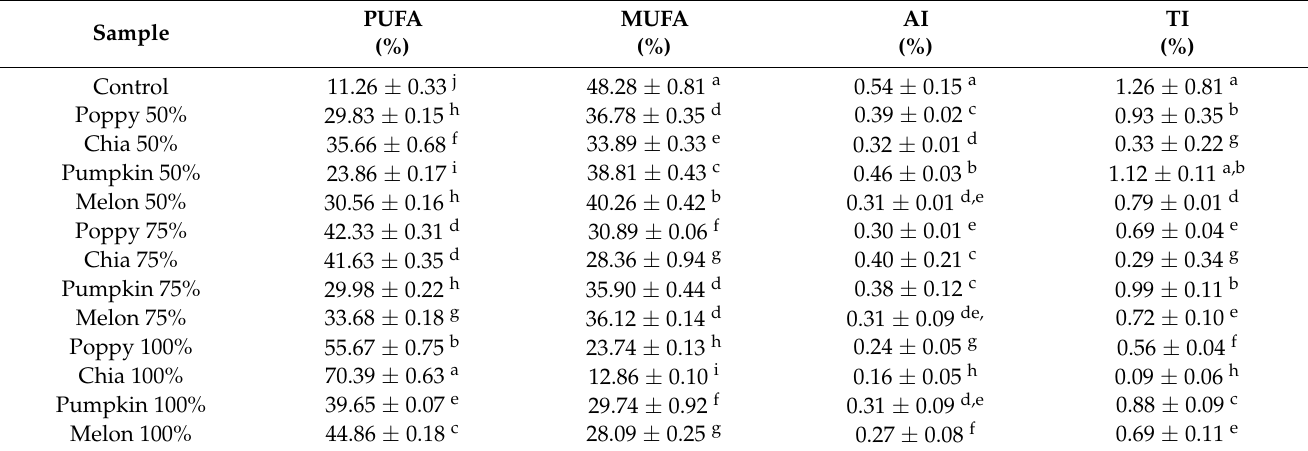
Table 7. Results obtained for the health indices (MUFA, PUFA, AI, and TI).